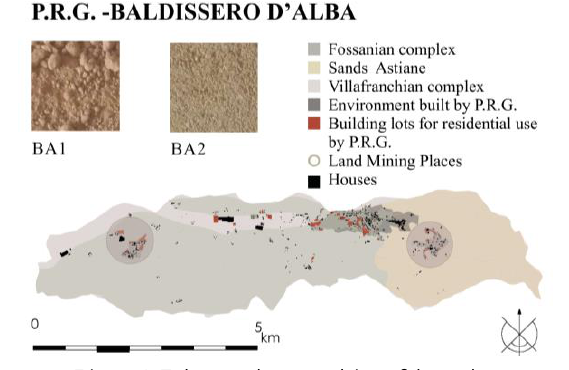
Figure 4. Taken earths, reworking of the authors.